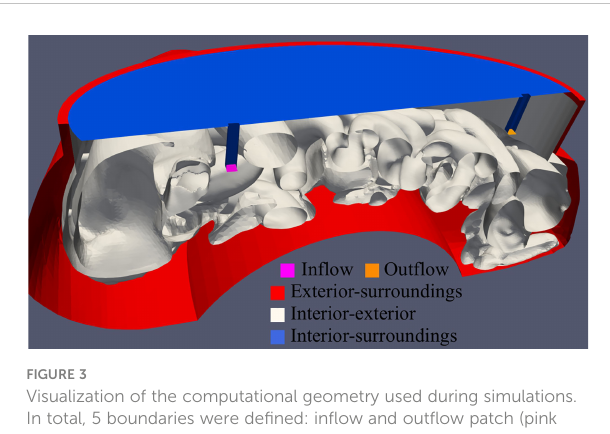
FIGURE 3 Visualization of the computational geometry used during simulations. In total, 5 boundaries were de fi ned: in fl ow and out fl ow patch (pink and orange, respectively), peritoneal exterior to the surroundings (red), peritoneal interior to the peritoneal exterior (white) and the peritoneal interior to the surroundings